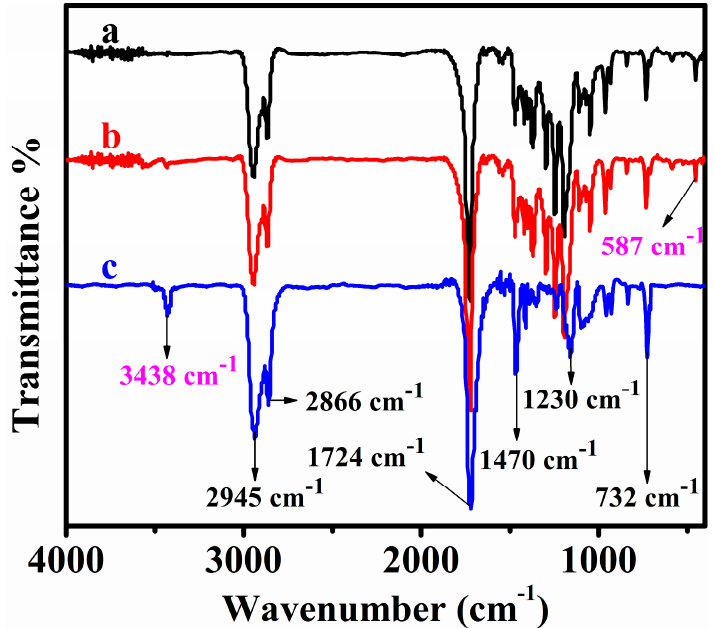
Figure 2. FT-IR spectra of product ( a ): 4-PCL; ( b ): 4-PCL treated with deionized water; ( c ): L-PCL.